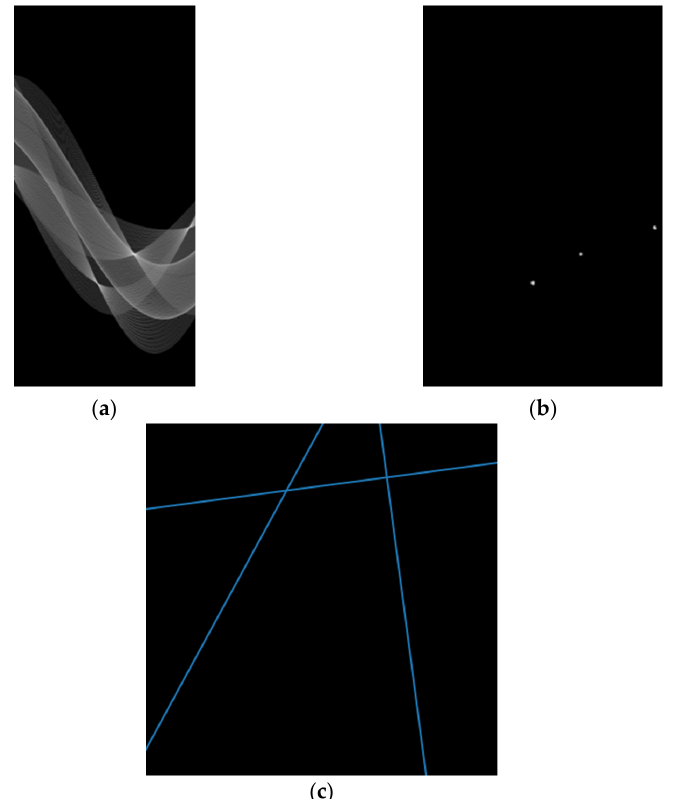
Figure 3. The process of the Hough fpn: ( a ) complete the result mapping an image from the image domain to the Hough domain, ( b ) perform convolution operation on the result from ( a ) to suppress noise to achieve adaptive point detection, and then ( c ) map the result in the Hough domain back to the image domain.